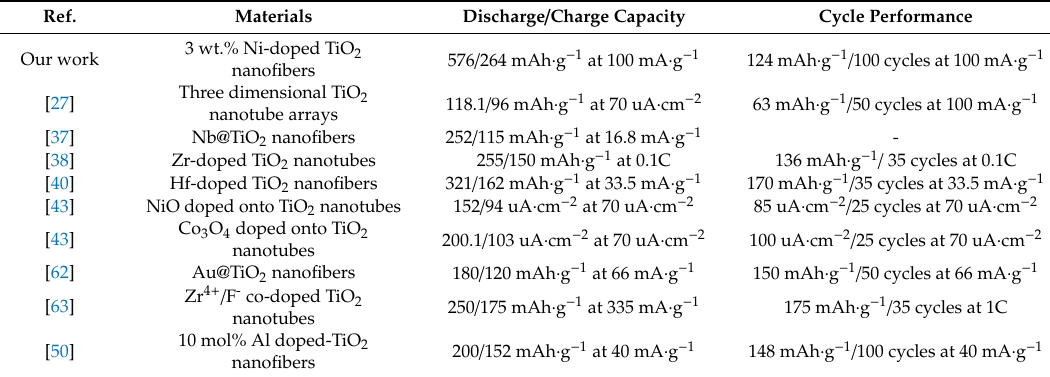
Electrochemical performance of nanostructured TiO 2 composites reported in some related